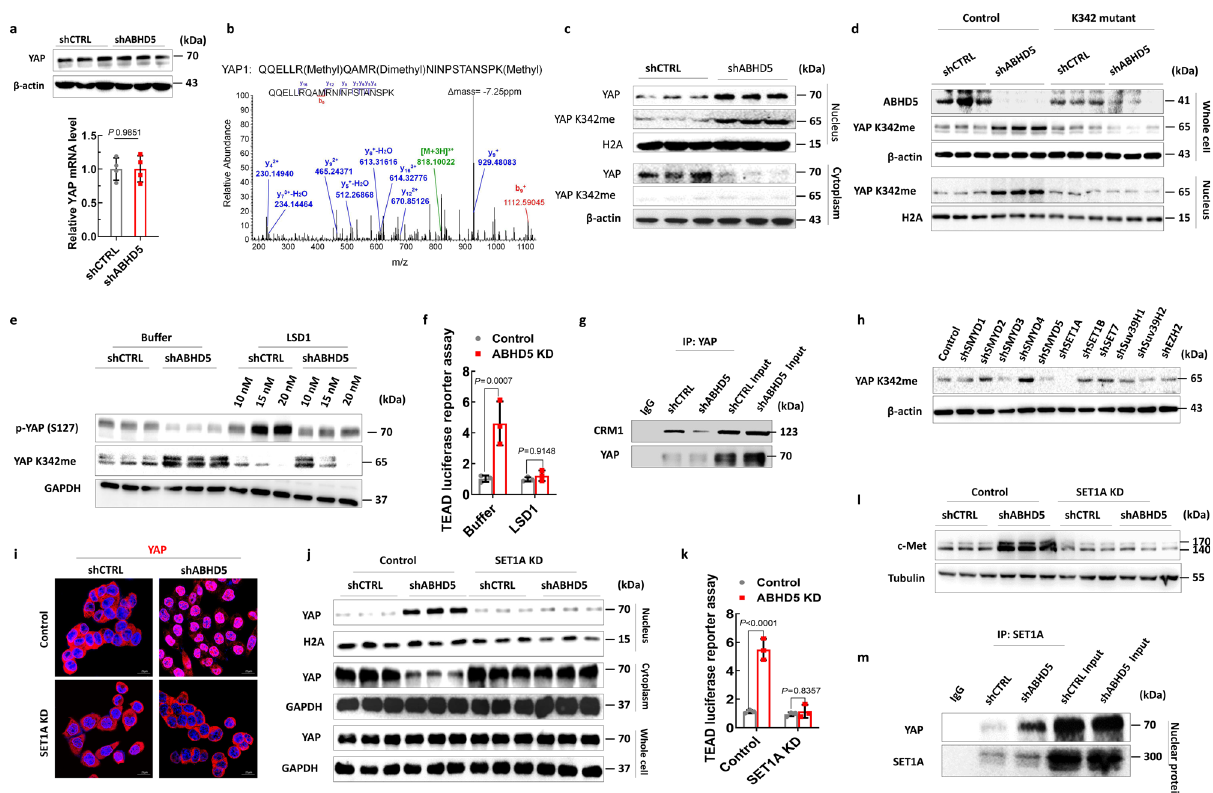
Fig. 5 ABHD5 de fi ciency promotes YAP activity and nuclear localization via inducing SET1A-mediated YAP methylation. a Real-time PCR and immunoblotting analyses of YAP expression levels in shCTRL or shABHD5 HCT116 cells ( n = 3 biologically independent samples). b Tandem mass spectrometry spectrum of Glu-C-digested YAP 332 – 349 fragment (methylated K342). Detected productions are indicated in red (b ions) and blue (y ions). c Subcellular factionation immunoblotting of YAP and methylated YAP at k342 (YAP K342me) in shCTRL or shABHD5 HCT116 cells . d Immunoblotting of YAP K342m expression levels in shCTRL or shABHD5 HCT116 cells transfected with control vector (pcDNA3.1) or YAP 342 mutant (K342 mutant). e Immunoblotting of phosphorylated YAP (p-YAP S127) and YAP K342m expression levels in shCTRL or shABHD5 HCT116 cell homogenates treated with control buffer or LSD1. f TEAD luciferase reporter assay in shCTRL or shABHD5 HCT116 cell homogenates treated with control buffer or LSD1 (20 nM) ( n = 3 biologically independent samples). g YAP immune complexes were immunoprecipitated from shCTRL or shABHD5 HCT116 cells and subjected